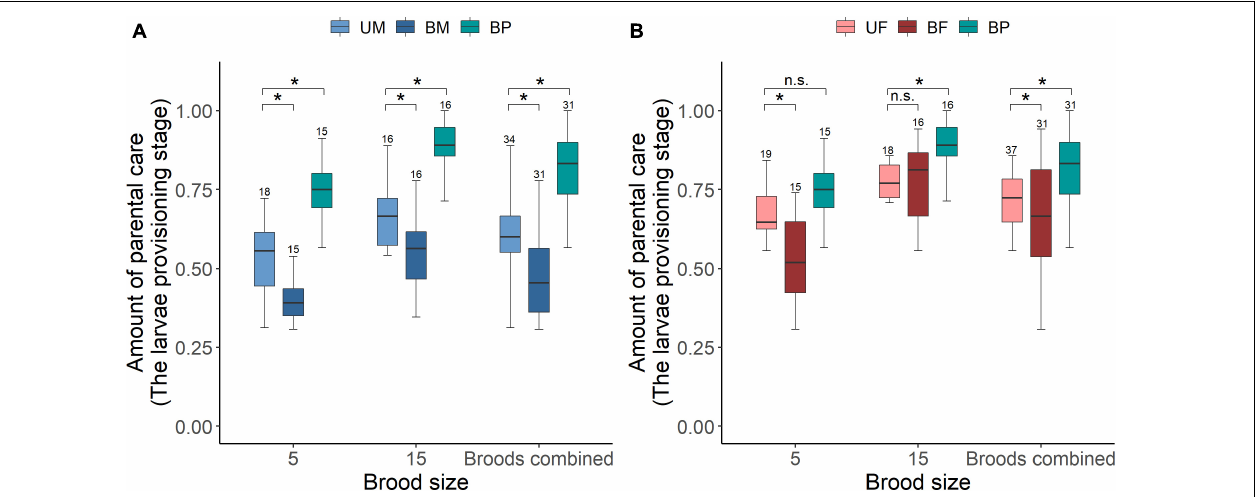
FIGURE 1 | The effect of parental care system (uniparental male, uniparental female, biparental male, and biparental female) and brood size (5 vs. 15 larvae) on the amount of parental care provided by (A) male and (B) female burying beetles in the first breeding. Boxplots show median, interquartile range, and minimum/maximum range. Numbers above error bars are sample sizes. For statistical analyses see Tables 2 – 4 . Asterisks, significant ( P < 0.05); n.s., not significant; UM, uniparental male; UF, uniparental female; BM, biparental male; BF, biparental female; BP, the total amount of parental care for biparental male and biparental female combined. TABLE 3 | Pairwise comparison (Tukey post hoc test) for the effect of parental care system (uniparental male, uniparental female, biparental male, and biparental female) on the amount of parental care and weight change of burying beetle parents during the larvae provisioning stage and the entire reproductive period in the first breeding.